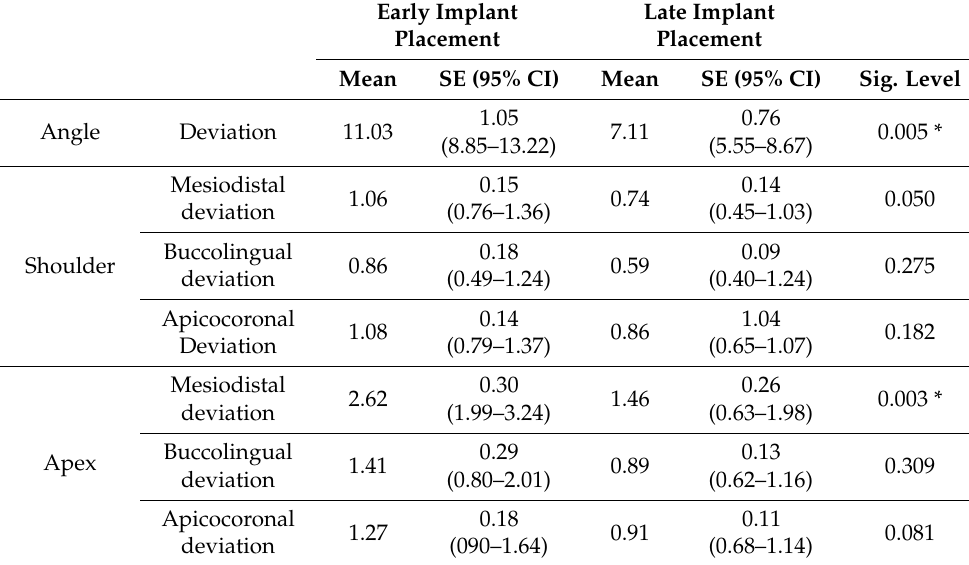
Table 7. Deviations between the planned and achieved implant position depending on the timing of implant placement. Early implantation (N = 21) Late implantation (N = 31). Angle variance ( ◦ ). Linear deviation (mm). Kruskal–Wallis test with a significance level of p <